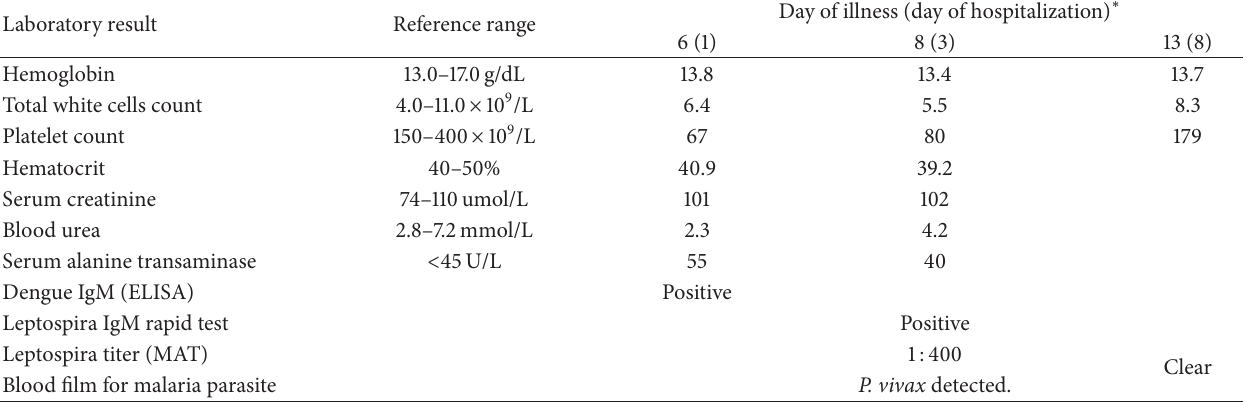
Table 1: Laboratory results on the first, third, and eighth day of hospitalization,